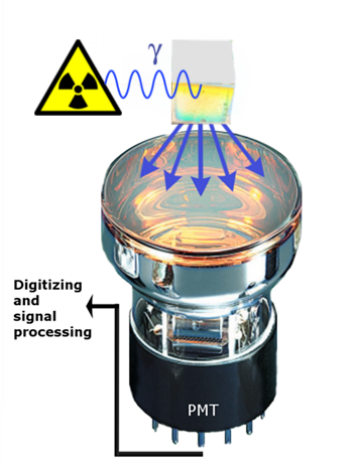
Figure 19. Schematic representation of the light yield bench. The radioactive source is placed close to the crystal; the light is collected at the photo-cathode of the photo-multiplier tube (PMT) and generates a voltage amplitude, then is digitized and analyzed in